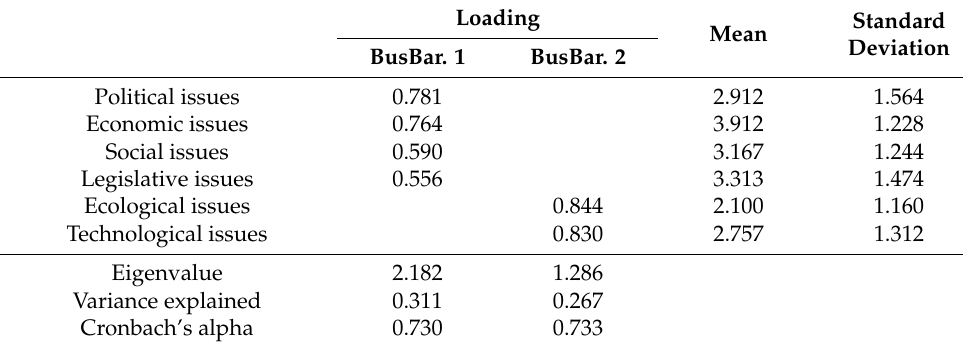
Table 4. Rotated component matrix: business barriers.